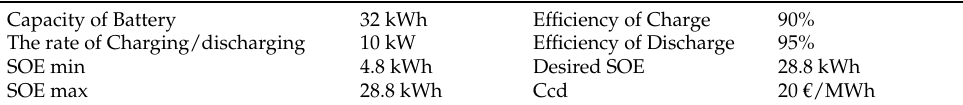
Table 3. EVs specification.